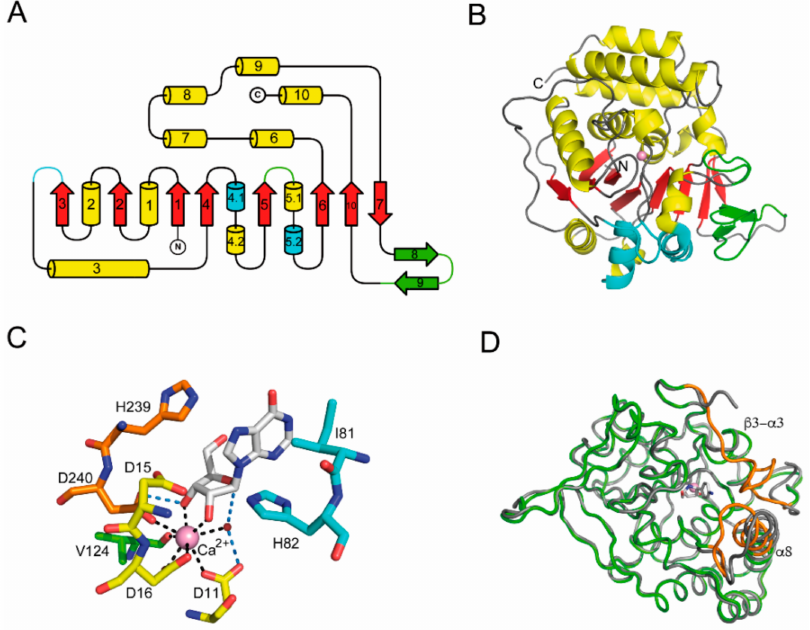
Figure 3. Group I NH structure. ( A ) Overall topology diagram of group I NHs. The major secondary structural elements shared by all group I NHs so far characterized are indicated ( α -helices as cylin- ders, β -strands as arrows). Occasionally, additional short helical segments are identified through automated analysis, thus the numbering may differ. Strands β 8 and β 9 (green) are components of the major interaction surface between group I monomers for tetramer assembly, while elements colored in cyan compose the minor interaction surface. ( B ) Ribbon diagram of the monomer of the epitomic C. fasciculata IU-NH (PDB code 2MAS). ( C ) Active site architecture of group I NHs. Here, the complex between the E. coli RihB/YeiK enzyme and inosine is shown. The Ca 2+ ion octacoordination is composed of three Asp residues from the NH sequon, the carbonyl oxygen of a non-conserved amino acid (commonly Thr, Val or Ile), one water molecule, and the O2’ and O3’ ribosyl hydroxyls. In the absence of a substrate, two ordered waters occupy the hydroxyl positions. Hydrogen bonds between the enzyme, substrate, and catalytic water are colored blue. Amino acids are colored according to the scheme in Figure 2. ( D ) Conformational changes in group I NHs on binding of active site ligands. The α 3- β 3 loop and helix α 8 are highly flexible in the structure determined in the absence of a ligand (gray tube), and undergo a transition to a defined conformation when active site ligands are bound (green tube, with the segments undergoing a structural transition colored